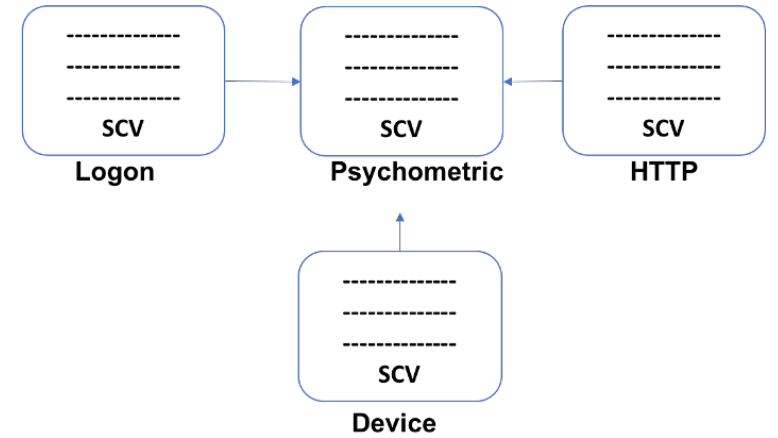
Figure 5. Illustration of the relations between the